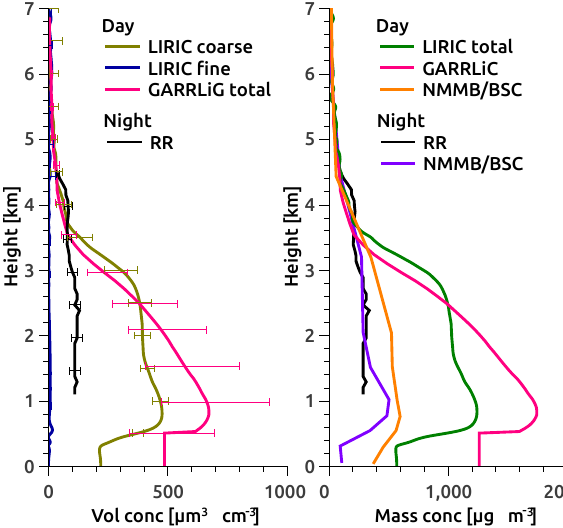
Figure 14. Volume (Vol conc) and mass (Mass conc) concentra- tion profiles for an event over the Dakar site on 10 April 2015. The abbreviation RR corresponds to V retrieved by using Raman and regularization